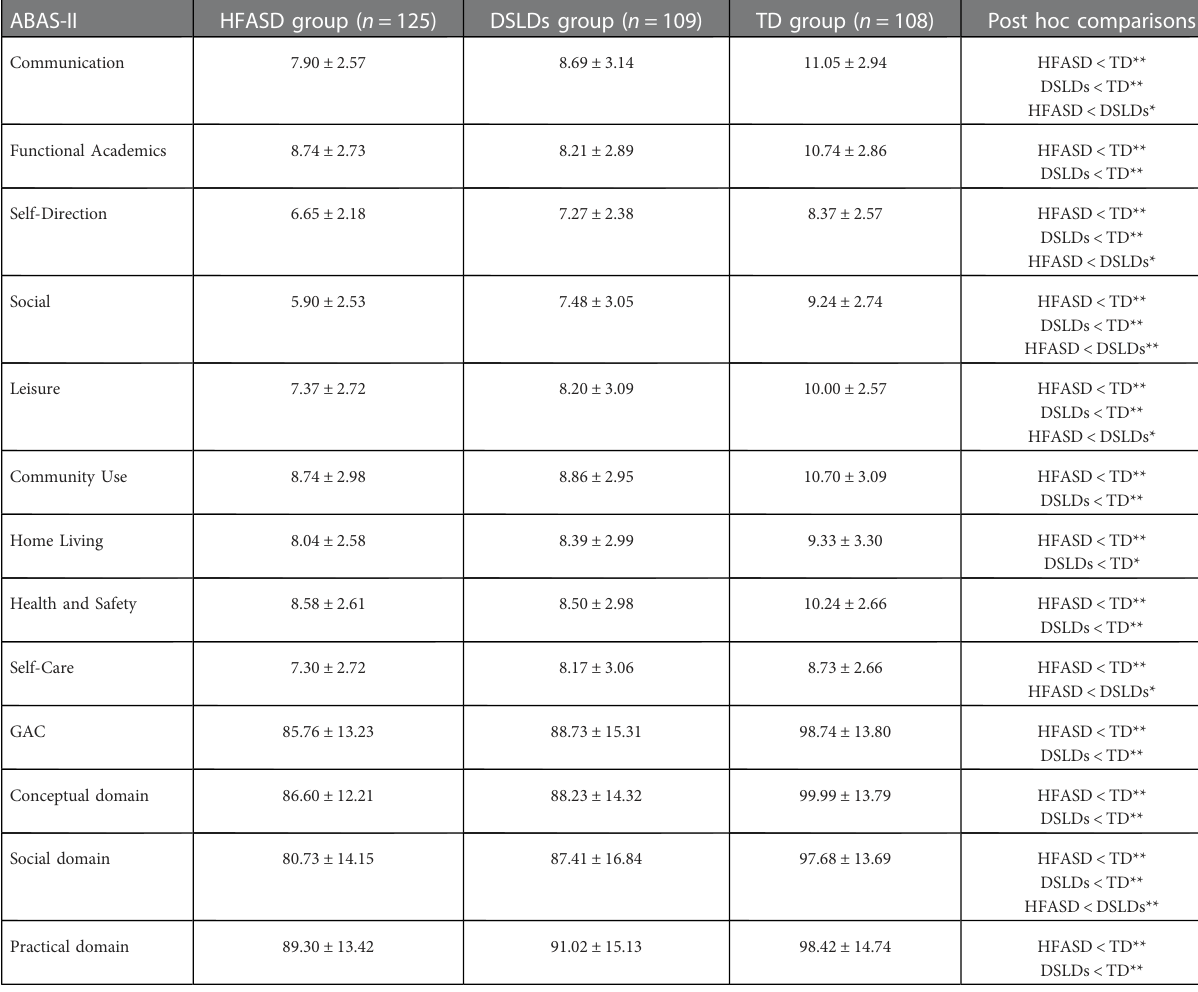
TABLE 3 Comparisons of adaptive behaviors among the HFASD, DSLDs and TD groups. ABAS-II HFASD group ( n = 125)